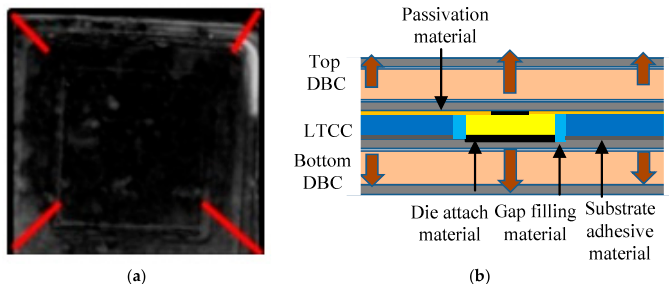
Figure 13. Recent wire bondless power module packaging efforts from the University of Arkansas showing: ( a ) a scanning acoustic microscope (SAM) image of solder delamination in the 2012 module, and ( b ) a schematic showing the design approach.